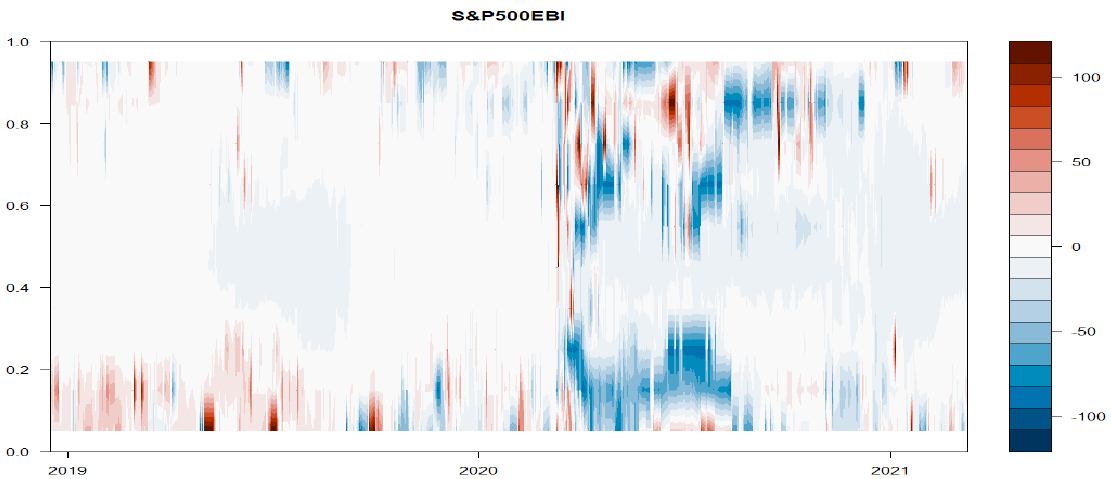
Figure 10. Results for net total directional connectedness for the S&P 500 Energy Index based on a 200-daysrolling-window QVAR(1) model and a 20-step-ahead forecast.